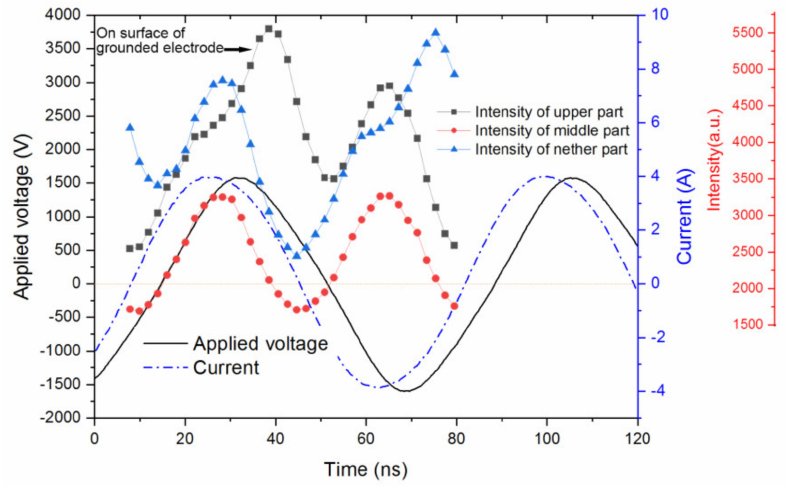
Figure 8. The voltage and current waveforms with emission intensities curves from Figures 5–7 (836 W).